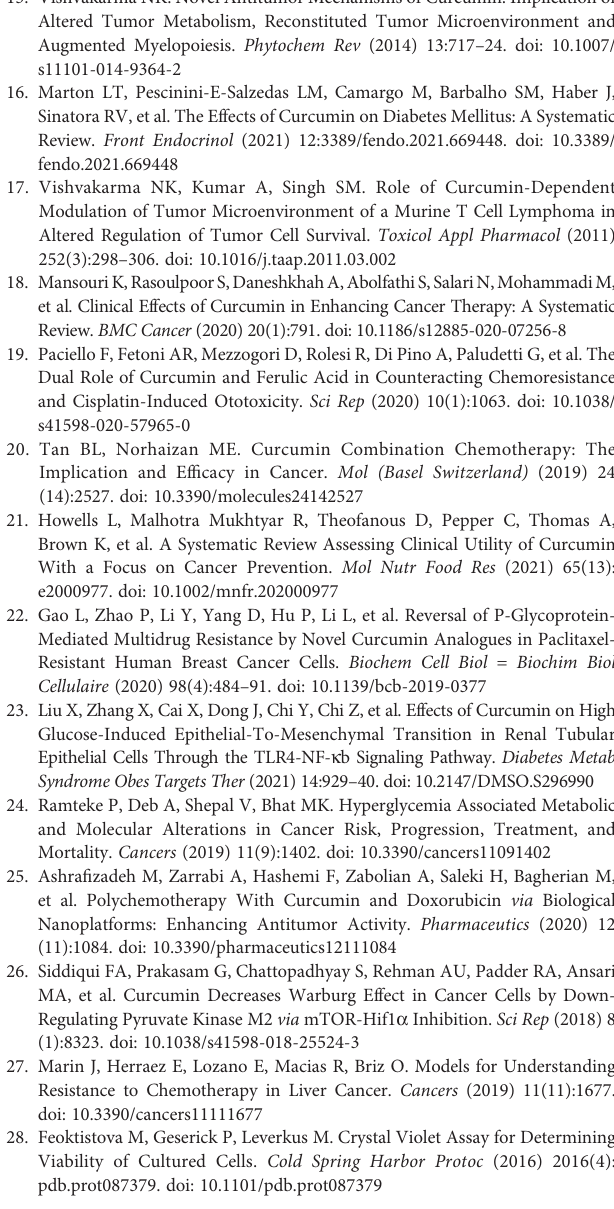
Supplementary Figure 1 | Invariable gene expression of b -actin. Cells were analyzed for gene expression of metabolic enzymes under different treatments. Intensitiesof b -actinbandsafterRT-PCRampli fi cationweredetermined andplotted against amount of template along with calculation of coef fi cient of correlation. Supplementary Figure 2 | Invariable b -actin gene expression. Cells were analyzed for gene expression of regulators of metabolic and